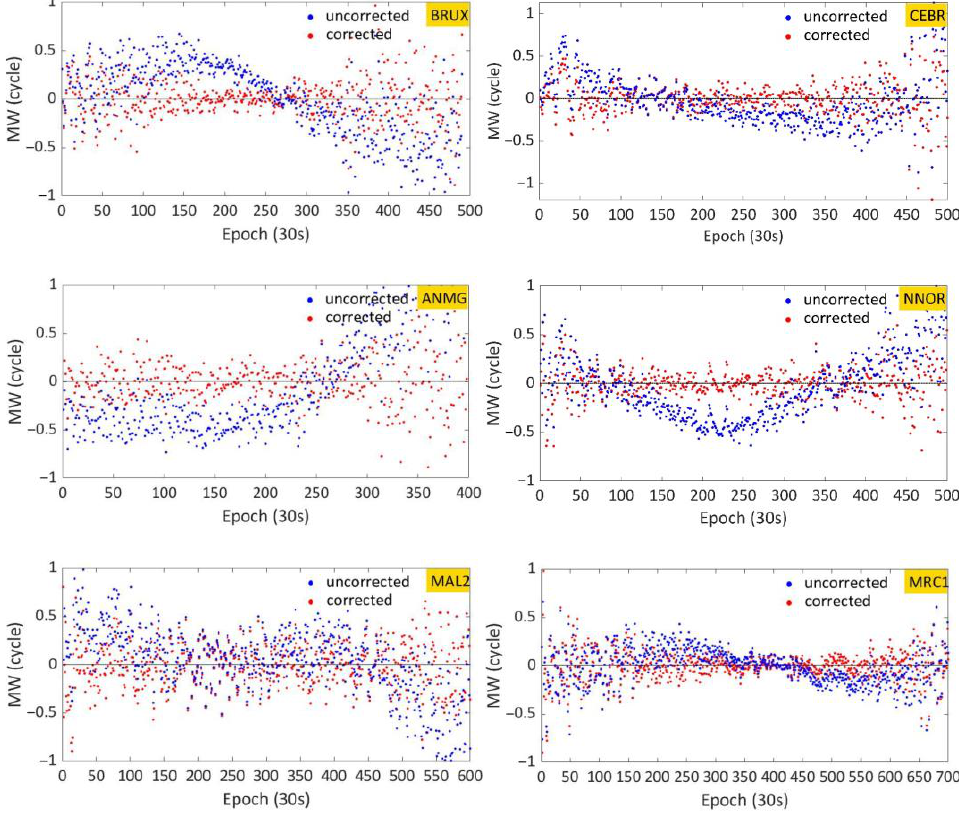
Figure 14. The MW combination time series on DOY 326, 2020, at LEIJ, FFMJ, BRUX, CEBR, ANMG, NNOR, MAL2, and MRC1 stations. The blue dots denote the original MW combination, and the red dots denote the corrected MW combination using the multi-site model.